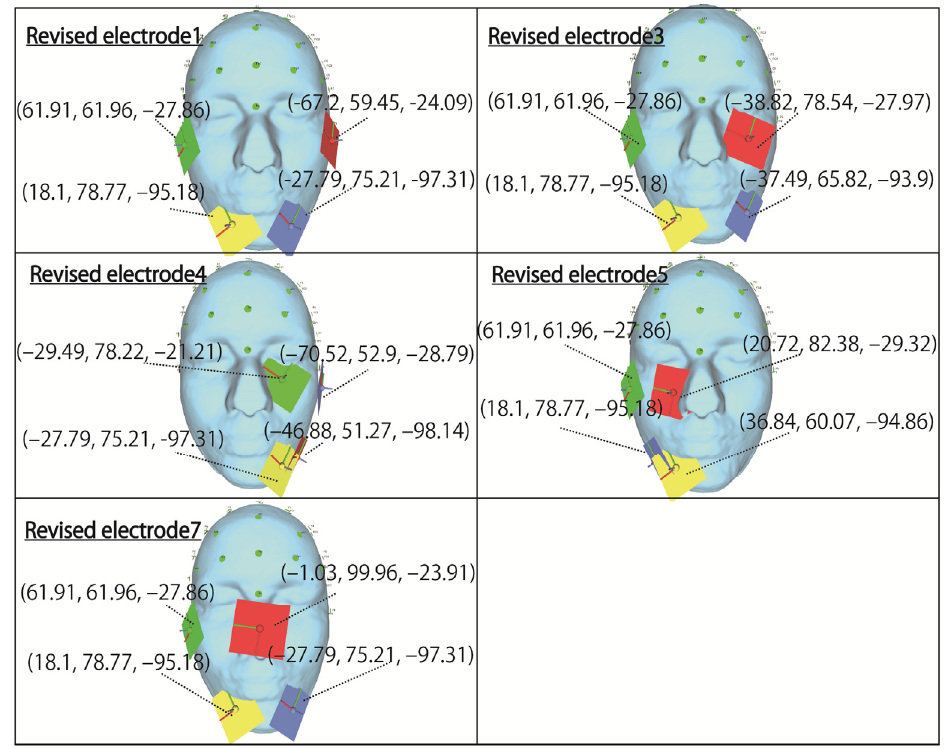
Figure 10. Revised electrode arrangements to improve the local stimulation.